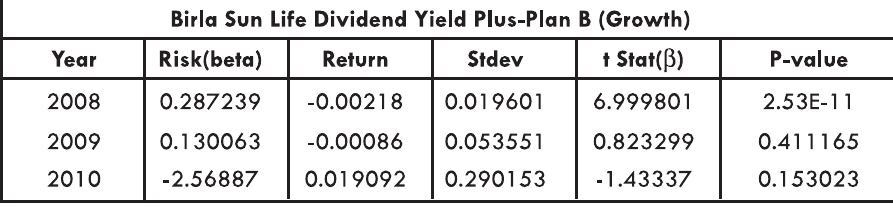
Table 11: Risk and Returns of Birla Sun Life Dividend Yield Plus-Plan B (Growth) Scheme during the Study Period (2008 to